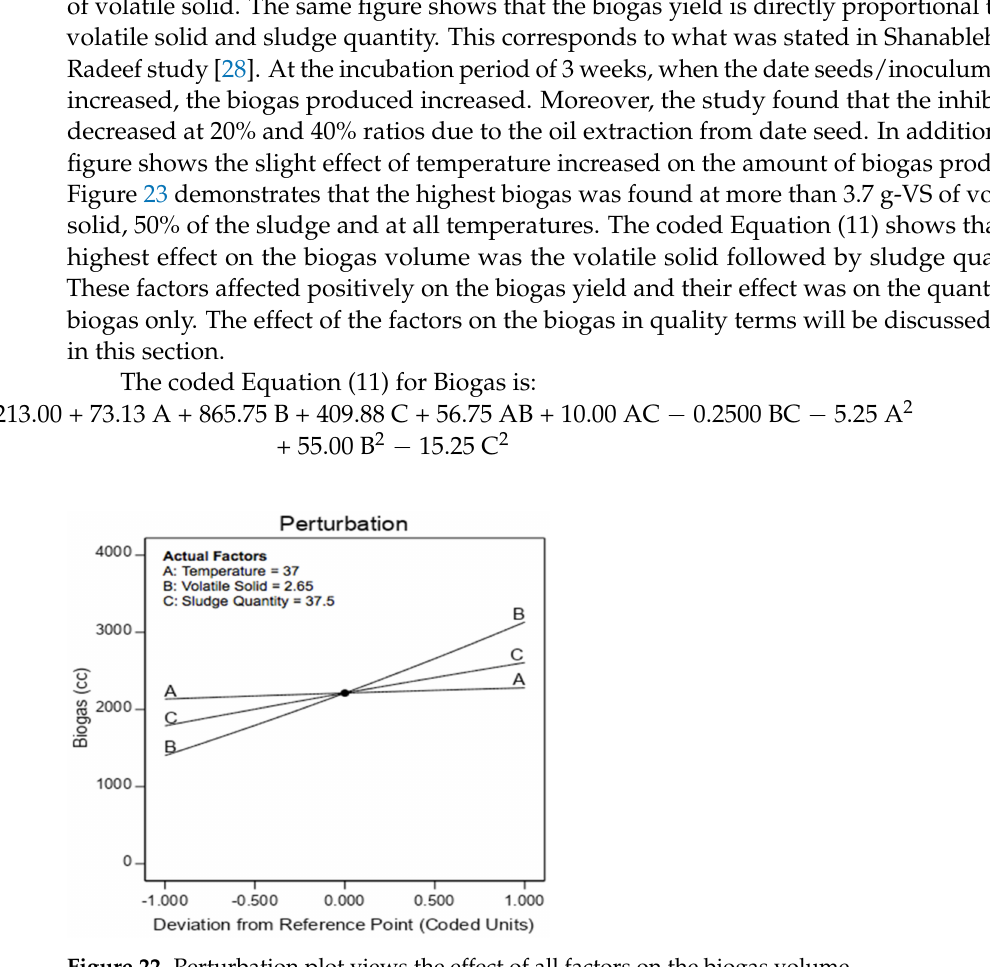
Figure 22. Perturbation plot views the effect of all factors on the biogas volume.